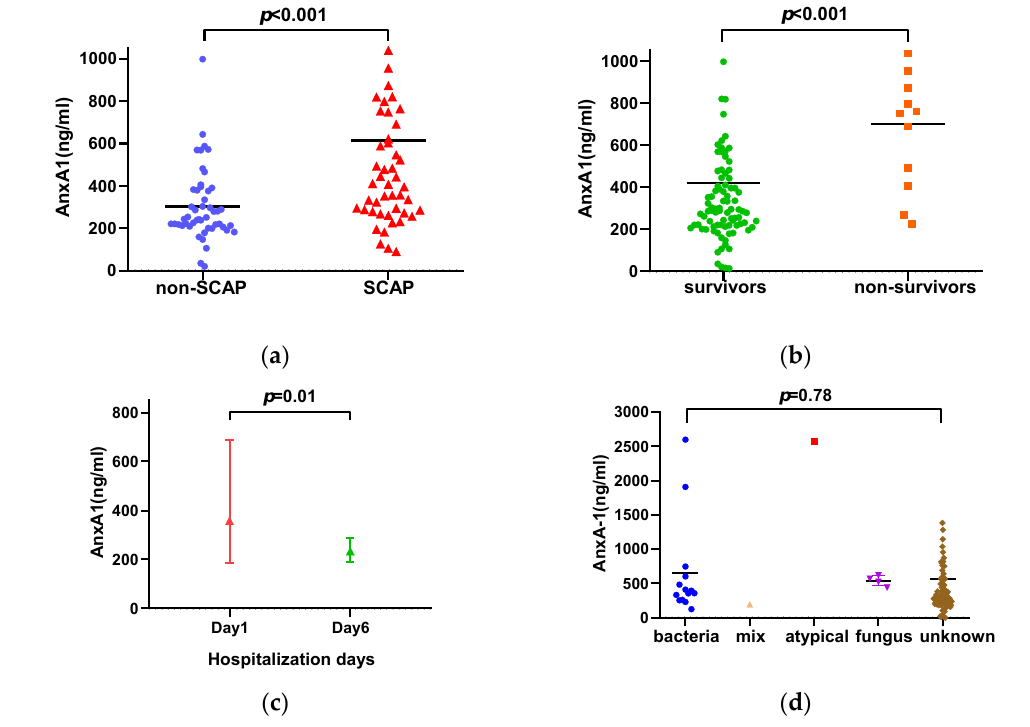
Figure 1. Serum AnxA1 level in patients with CAP. ( a , b ) AnxA1 level in patients with non-SCAP (blue circles) and SCAP (red triangles) ( a ) and in survivors (green circles) and non-survivors (orange squares) ( b ). ( c ) Serial change in serum AnxA1 concentration after treatment. ( d ) Comparison of AnxA1 level in patients with different CAP etiologies including bacteria, atypical pathogen (including Mycoplasma pneumoniae , Chlamydia pneumoniae , and Legionella pneumophila ), mixed pathogen, and unknown pathogen. p = 0.78 for intergroup comparison. Each point represents the median value.